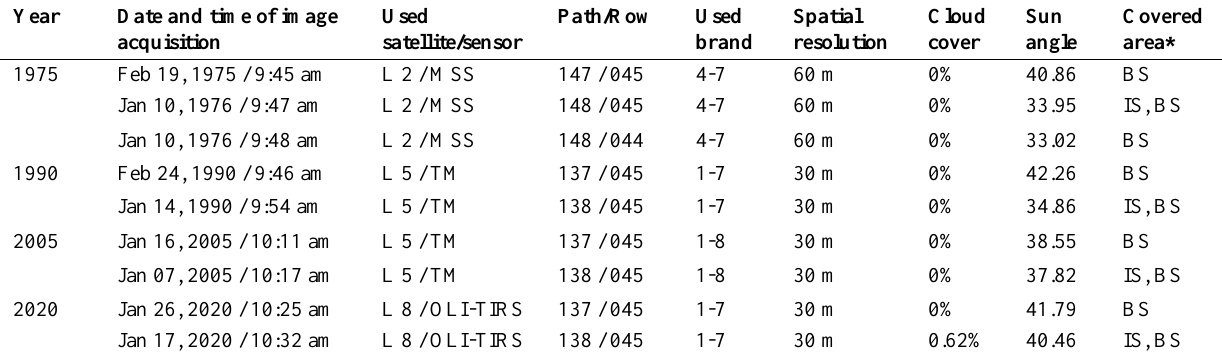
Table 1. Source and specification of satellite images used in the study. Covered area*: BS=Bangladesh Sundarbans, IS=Indian